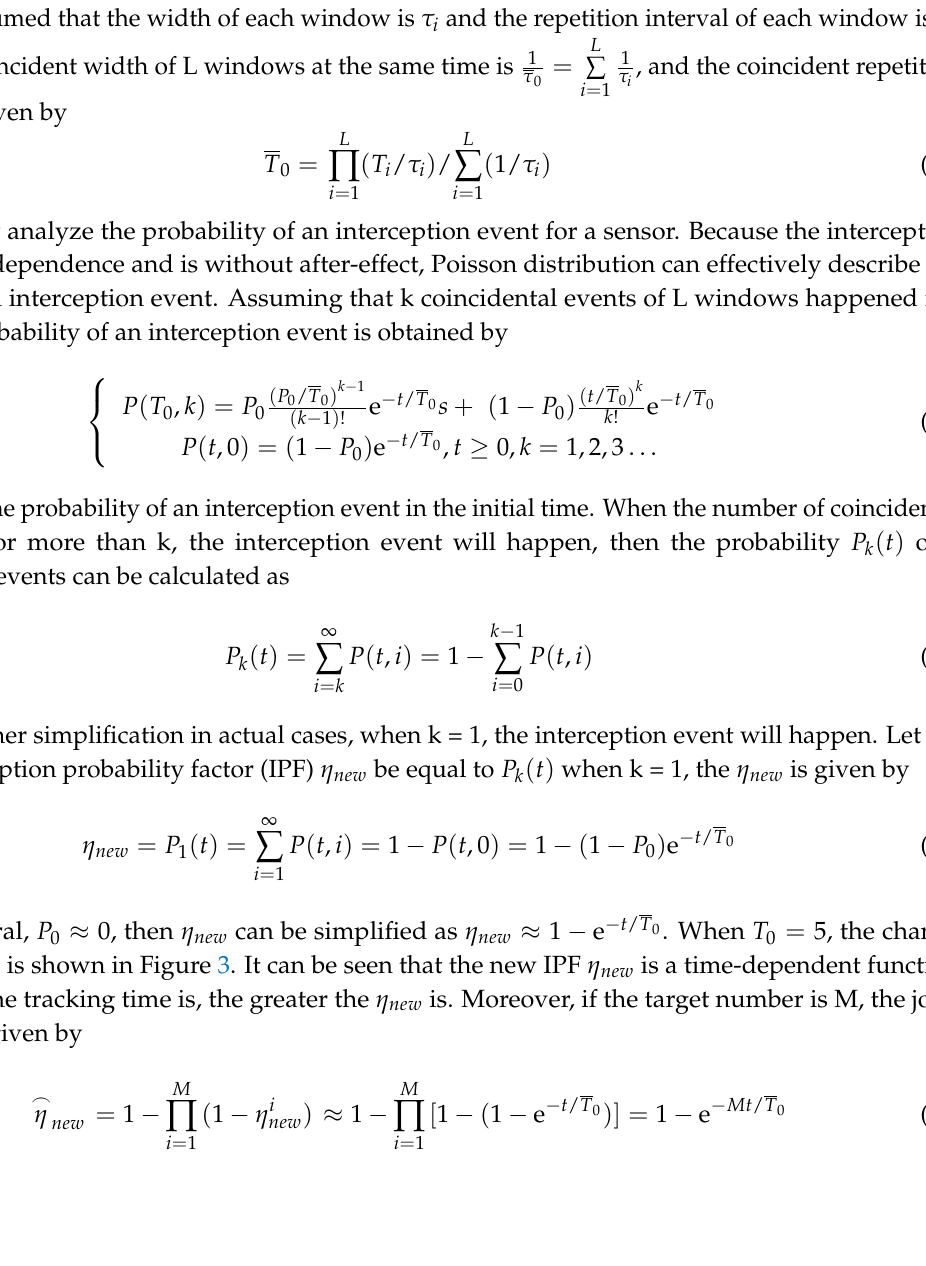
Figure 2. Basic window functions and the time overlap of them.